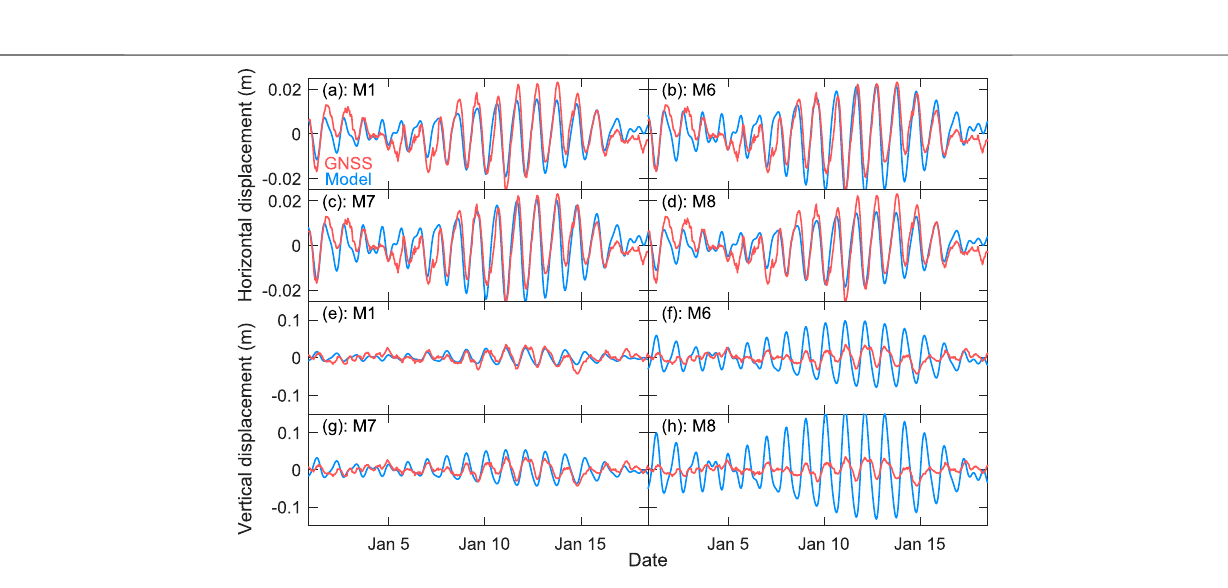
Frontiers in Earth Science |